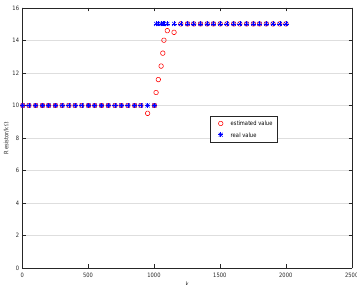
Figure 1. Real value vs. estimated value of Strong Tracking Unscented Kalman Filter ( STUKF ) for jump type fault.